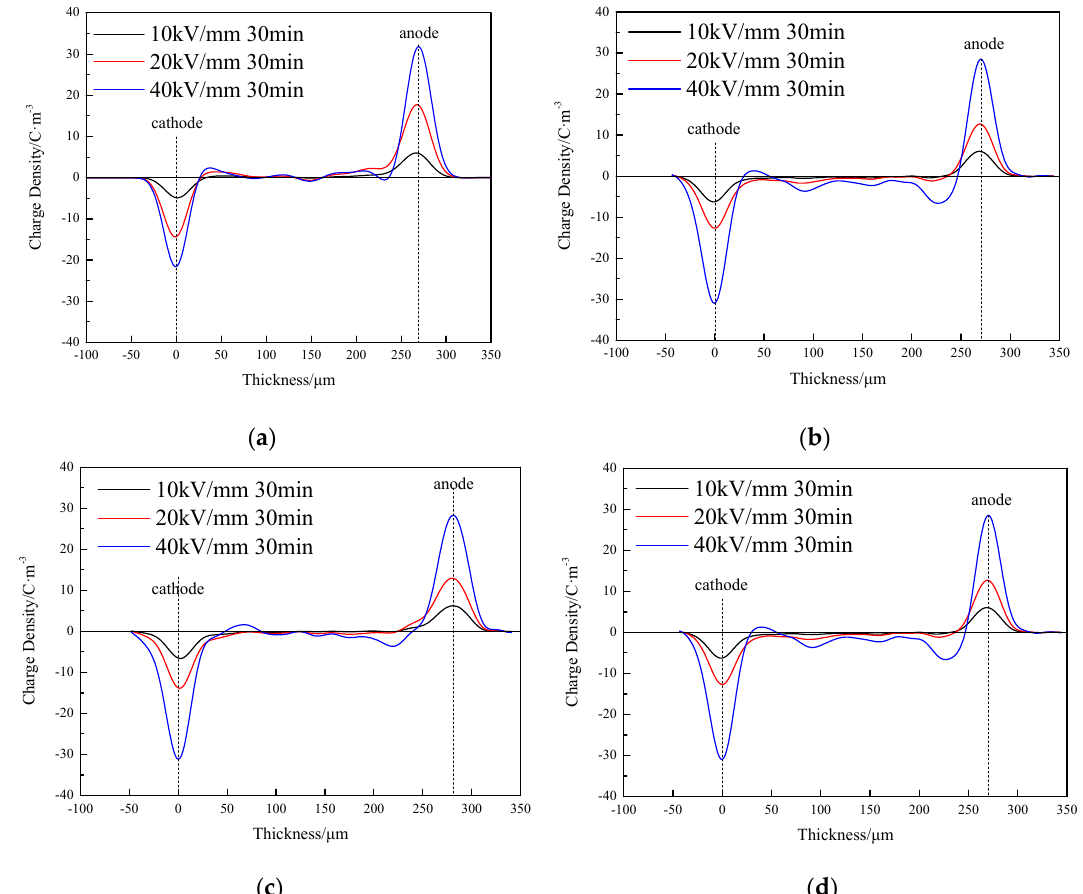
Figure 5. Space charge distribution of ZnO/LDPE with different kinds of composites under an electric field: ( a ) LDPE, ( b ) N3, ( c ) M3, and ( d ) N2M1.